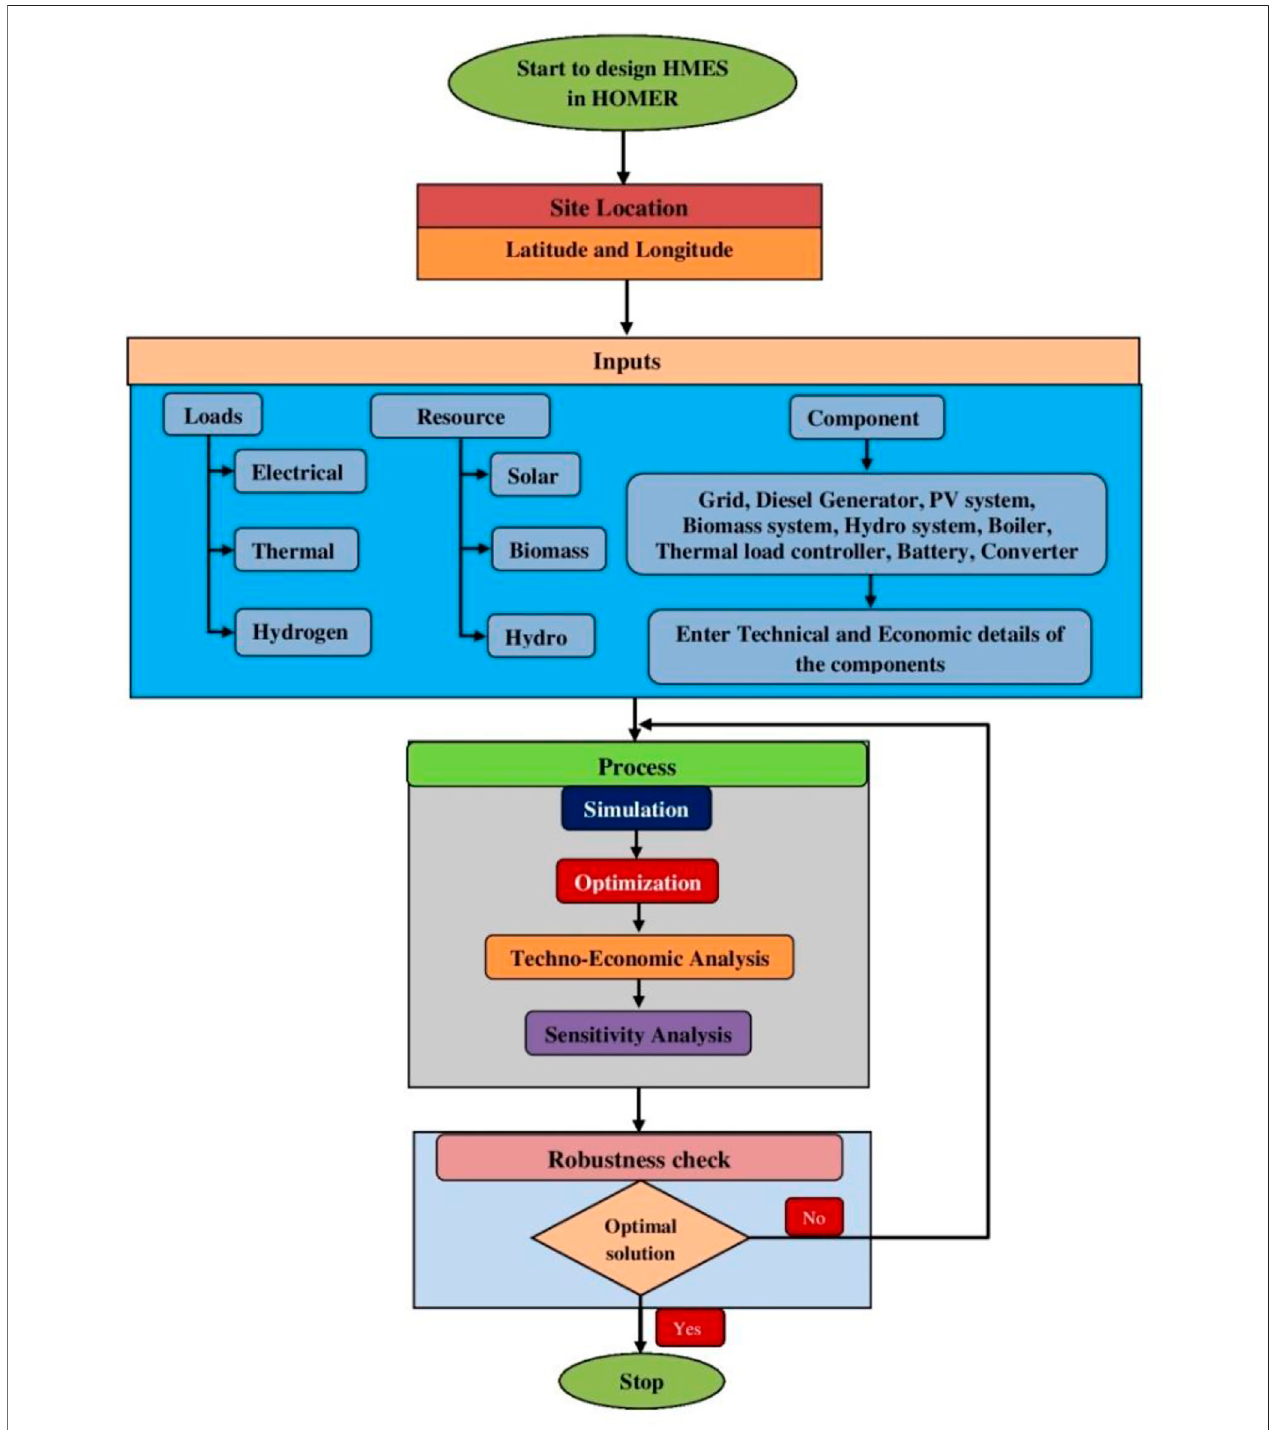
FIGURE 3 | Diagrammatic representation of HOMER